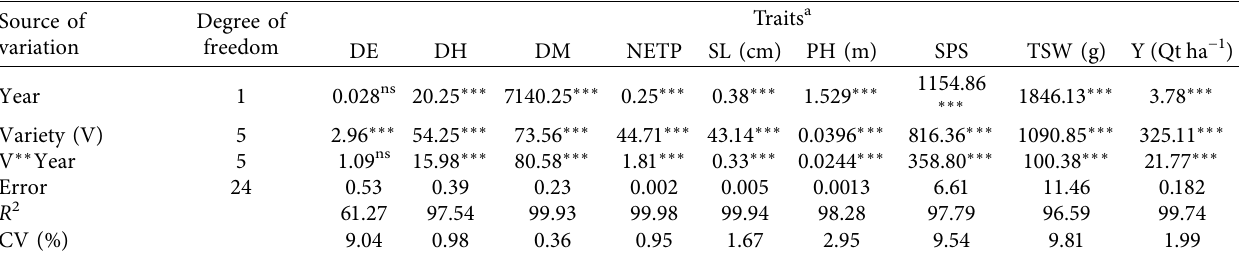
Table 3: Mean squares of yield and yield-related components of malt barley in 2019 and 2020 main cropping season. Source of Degree of variation